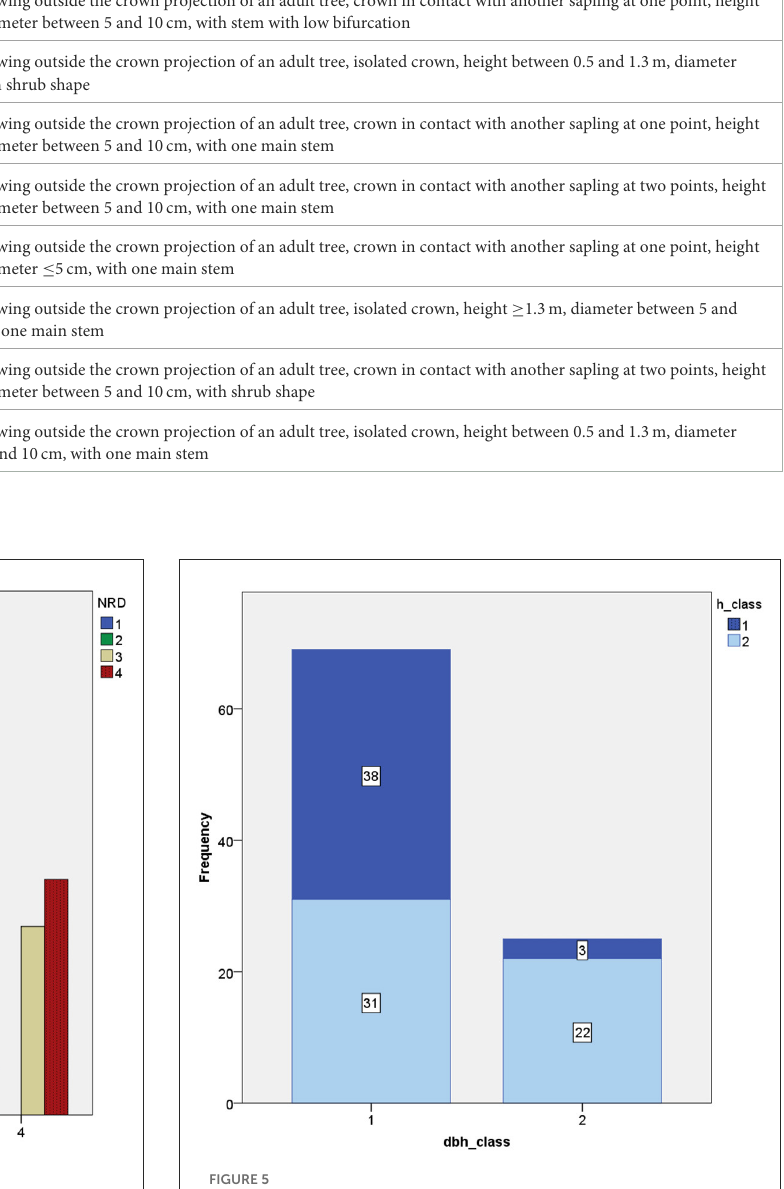
were touching at two points, and no saplings were surrounded by other saplings (degree of crown isolation 4). Approximately 44% of the saplings had a height between 0.5 and 1.3 m, while 56% were taller than 1.3 m. Most of the saplings (73%) had a dbh of ≤ 5cm, and 27% of the saplings were between 5 and 10